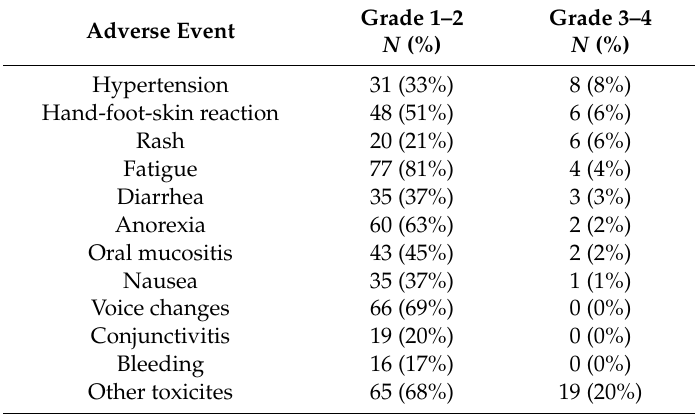
Table 2. Toxicity analysis of 95 patients evaluable for toxicity. The most common toxicities are listed according to frequency of minor toxicity, grade 1–2, and major toxicity, grade